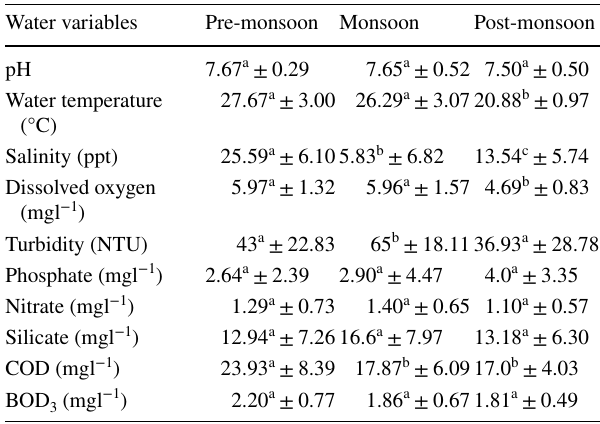
Table 1 Seasonal variation of water quality parameters in the study sites of Sundarbans